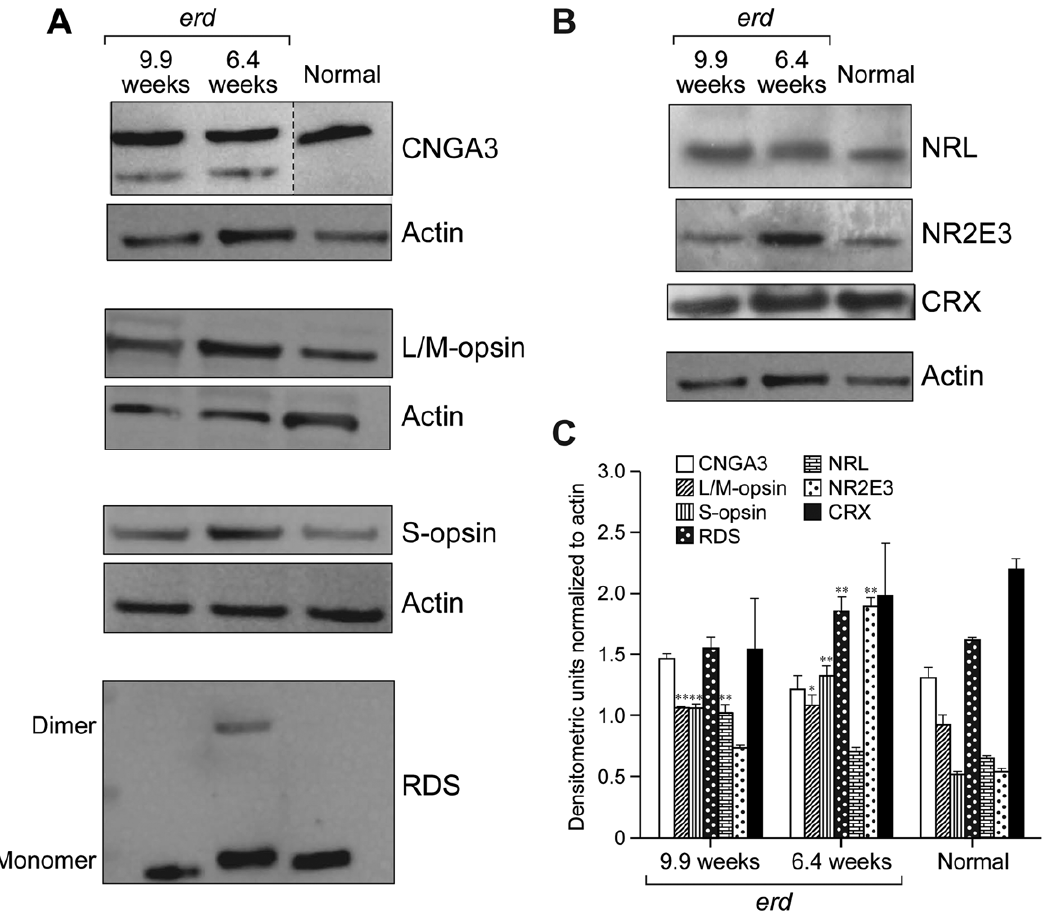
Figure 7. Protein expression in erd retina. Expression of ( A ) CNGA3, L/M-opsin, S-opsin, RDS, and ( B ) NRL, NR2E3, CRX proteins in cleared whole retinal lysates. ( C ) Net intensity densitometric values are expressed as corrected net intensity of the sample normalized to corrected net intensity of actin loading controls. Actin loading control is the same for S-opsin and RDS, and for NRL, NR2E3 and CRX, respectively. Results are the mean 6 SD of four independent densitometer scans of two individual westerns. Confidence levels: *=95%,